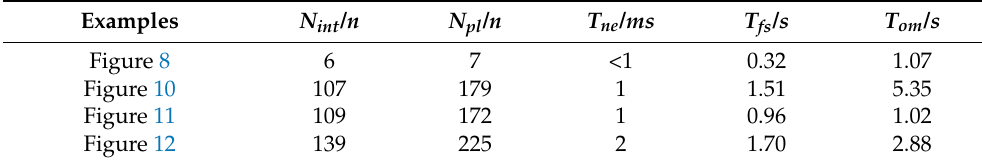
Table 1. Experimental data statistics, including the intersection point number ( N int ), the polyline number ( N pl ), the normal estimation time ( T ne ), the function solving time ( T fs ) and the overall modeling time ( T om